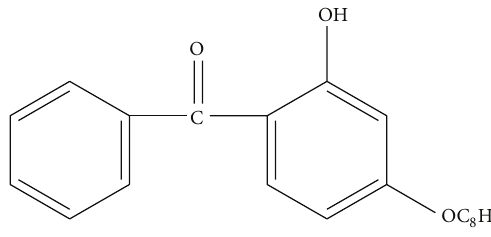
Figure 1: Chemical structure of